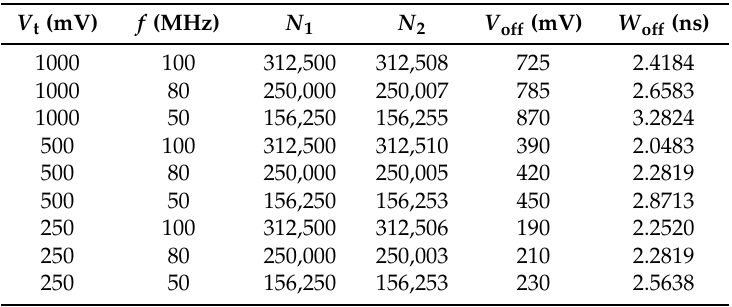
Table 3. Statistics of sinusoidal pulse by the data acquisition module.